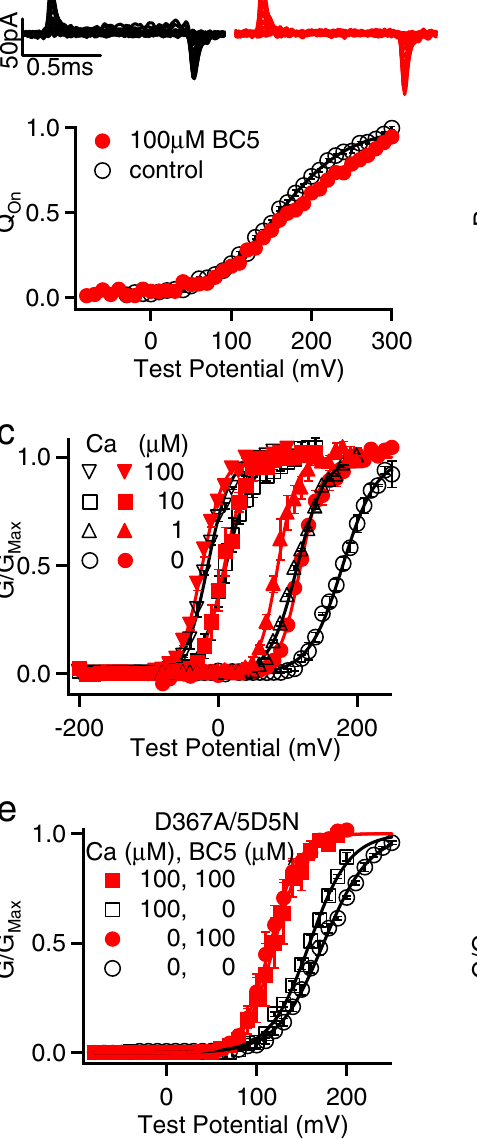
Fig.3|BC5perturbsCa 2+ -dependentactivation.a Top,gatingcurrentsincontrol and 100 µ M BC5.Voltage pulses werefrom − 80 to 300mV with 20mV increments. Bottom,Normalizedgatingcharge-voltage(QV)relationofon-gatingcurrents.The smoothlinesare fi tstotheBoltzmannfunction, n =14forcontrol,and n =7forBC5. b Top,current traces ofa patchcontaining hundredsof BKchannelsat − 140mV in control and 100 µ M BC5. Only brief unitary channel openings were seen at the negative voltage. O: open; C: closed. Bottom, Open probability (Po) at negative voltages, n =9 for control,and n =3 for BC5. c GV relations in various [Ca 2+ ] i (black hollowsymbols)andinadditionof100 µ MBC5(red fi lledsymbols).Blacksolidlines are Boltzmann fi ts without BC5 while red solid lines are Boltzmann fi ts with BC5.